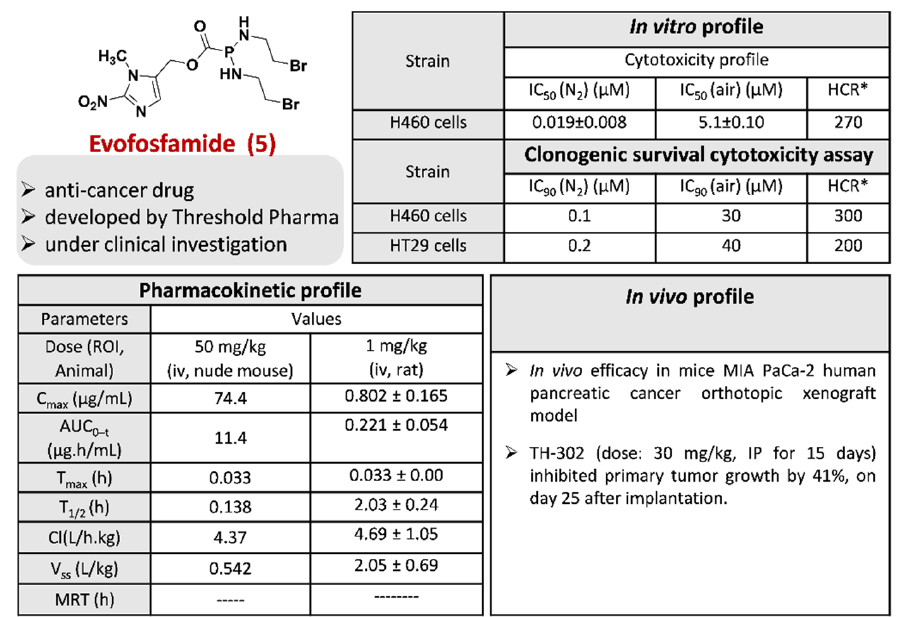
Figure 8. Activity profile of Evofosfamide 5 [67–70]. *: Hypoxia cytotoxicity ratio (HCR) was de- termined by the differential cytotoxicity under normoxic and hypoxic conditions: HCR=IC 50 (air)/IC 50 (N 2